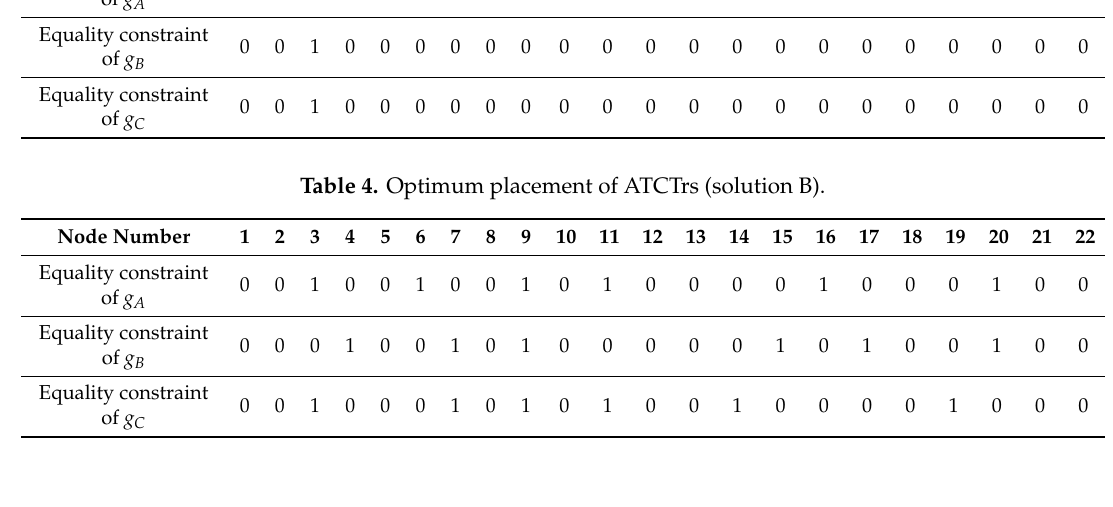
Table 5. Optimum placement of ATCTrs (solution C).